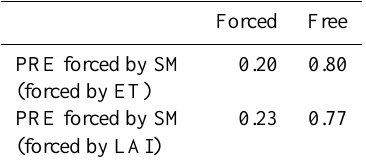
Table 5. Ratios of the global-scale forced and free variance with respect to the total variance resulting from the application of the CM technique between PRE forced by SM and ET as well as